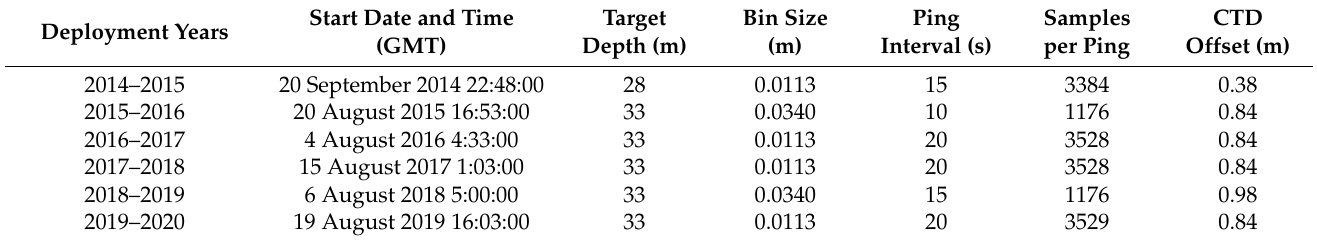
Table 1. Details for each annual AZFP deployment, including the start time, target depth for the top of the CEO mooring frame, bin size, ping rate, and samples recorded. The CTD offset is an estimate of the distance between the pressure sensor and the AZFP transducer on the